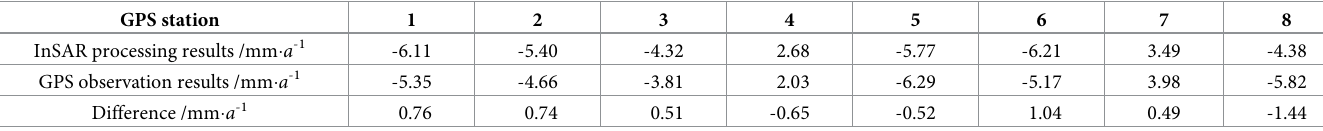
Table 2. Comparison between time series of InSAR processing and GPS measurements